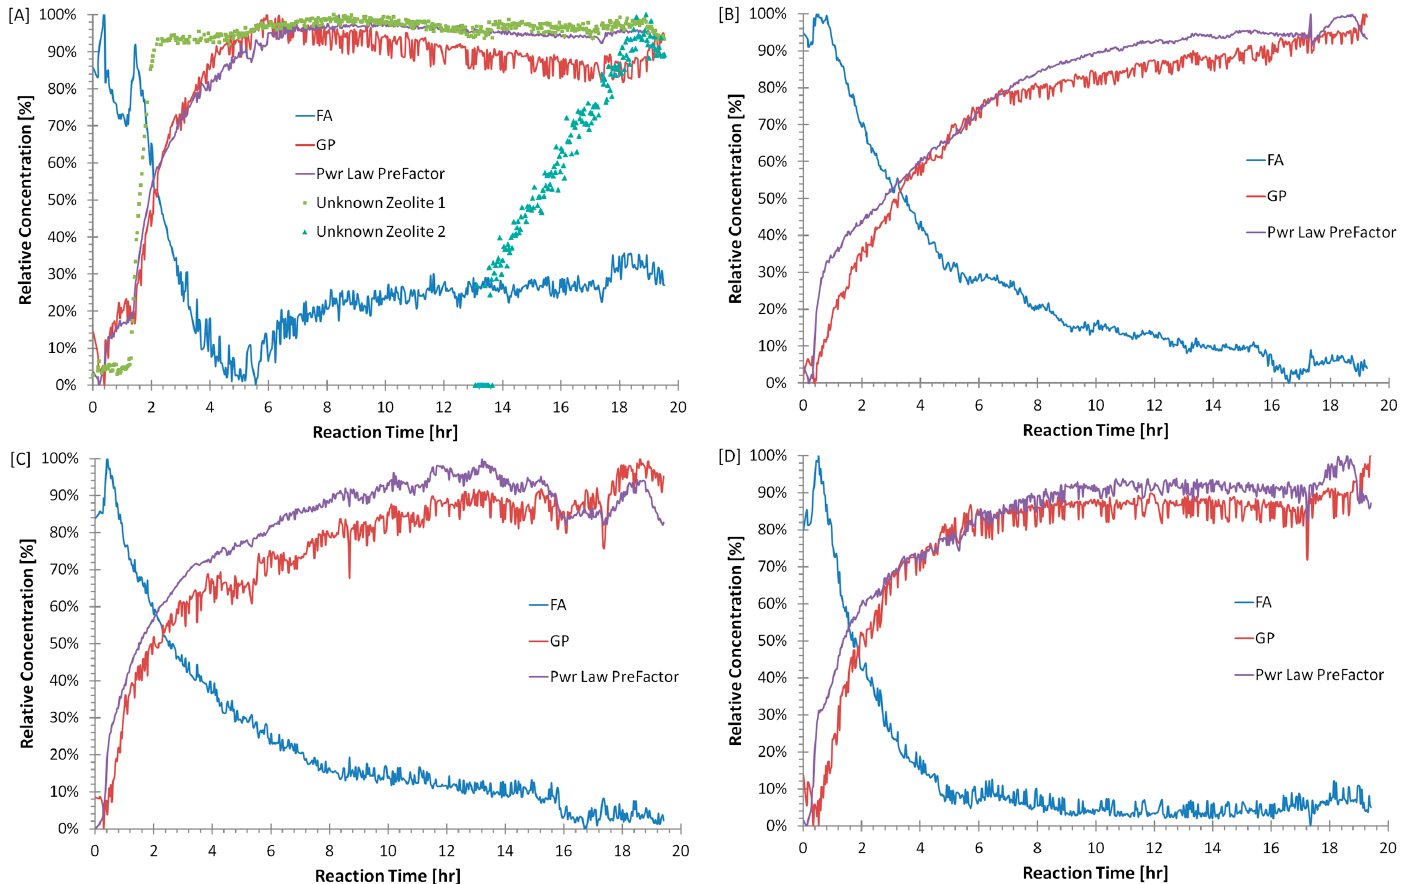
Figure 7. Refined output from WAXS data for samples: ( A ) CFA-1.8-0.8-5.5; ( B ) CFA-2.0-1.2-5.5; ( C ) CFA-2.0-0.8-5.5 ( D ) CFA-2.2-0.8-5.5; the time evolution of the diffuse scattering peaks of flyash (FA) and geopolymer (GP) compared with the Power Law pre factor. Note for plot ( A ), that the induction period for zeolite 1 and geopolymer are approximately equal.